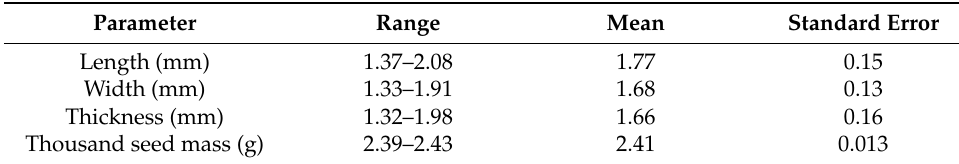
Table 1. Measured dimensions of Brassica chinensis